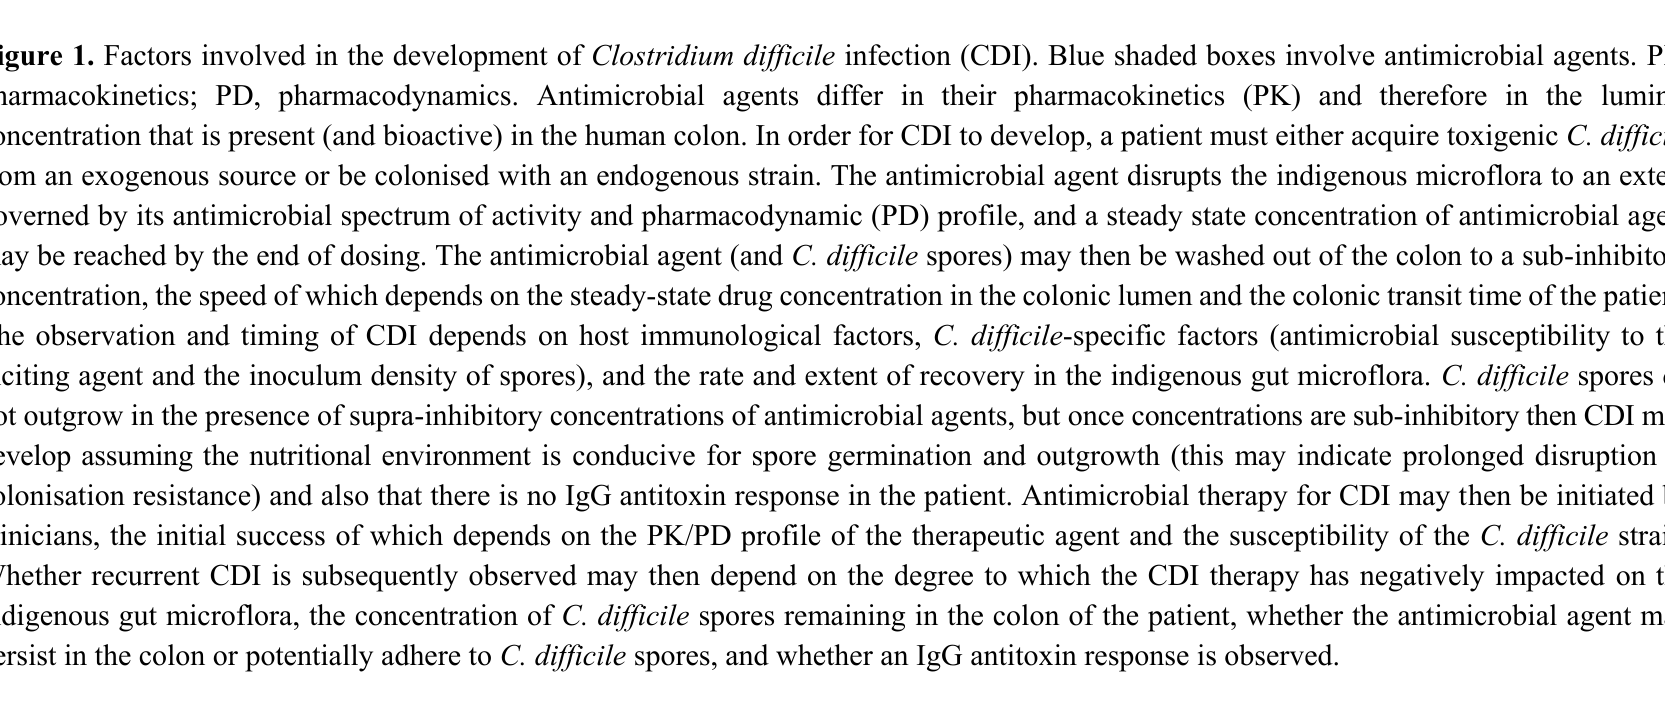
Figure 1. Factors involved in the development of Clostridium difficile infection (CDI). Blue shaded boxes involve antimicrobial agents. PK, pharmacokinetics; PD, pharmacodynamics. Antimicrobial agents differ in their pharmacokinetics (PK) and therefore in the luminal concentration that is present (and bioactive) in the human colon. In order for CDI to develop, a patient must either acquire toxigenic C. difficile from an exogenous source or be colonised with an endogenous strain. The antimicrobial agent disrupts the indigenous microflora to an extent governed by its antimicrobial spectrum of activity and pharmacodynamic (PD) profile, and a steady state concentration of antimicrobial agent may be reached by the end of dosing. The antimicrobial agent (and C. difficile spores) may then be washed out of the colon to a sub-inhibitory concentration, the speed of which depends on the steady-state drug concentration in the colonic lumen and the colonic transit time of the patient. The observation and timing of CDI depends on host immunological factors, C. difficile -specific factors (antimicrobial susceptibility to the inciting agent and the inoculum density of spores), and the rate and extent of recovery in the indigenous gut microflora. C. difficile spores do not outgrow in the presence of supra-inhibitory concentrations of antimicrobial agents, but once concentrations are sub-inhibitory then CDI may develop assuming the nutritional environment is conducive for spore germination and outgrowth (this may indicate prolonged disruption of colonisation resistance) and also that there is no IgG antitoxin response in the patient. Antimicrobial therapy for CDI may then be initiated by clinicians, the initial success of which depends on the PK/PD profile of the therapeutic agent and the susceptibility of the C. difficile strain. Whether recurrent CDI is subsequently observed may then depend on the degree to which the CDI therapy has negatively impacted on the indigenous gut microflora, the concentration of C. difficile spores remaining in the colon of the patient, whether the antimicrobial agent may persist in the colon or potentially adhere to C. difficile spores, and whether an IgG antitoxin response is